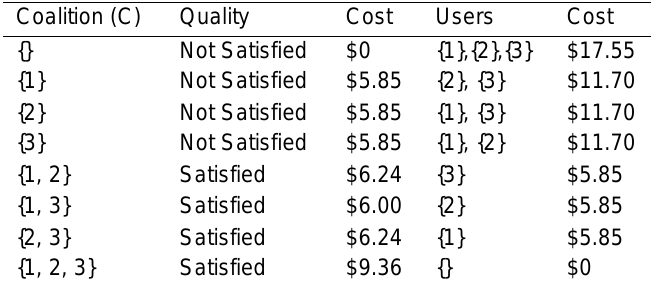
Table 3. Shapely Value of